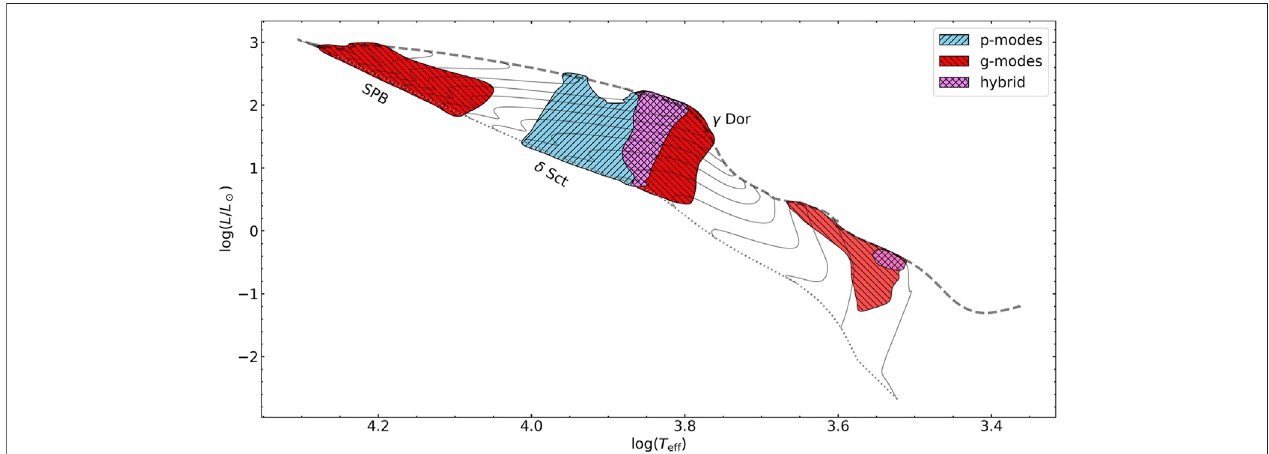
FIGURE 3 | Pre-main sequence instability regions in the Hertzsprung-Russell diagram. The colored areas depict the regions for which stellar pulsations are expected to be excited according to the results of Steindl et al. (2021a). The dashed grey line shows the evolutionary track of an accreting protostar with time-constant accretion rate. The thin grey lines show the subsequent pre-main sequence evolutionary track evolution and the dotted line indicates the ZAMS.